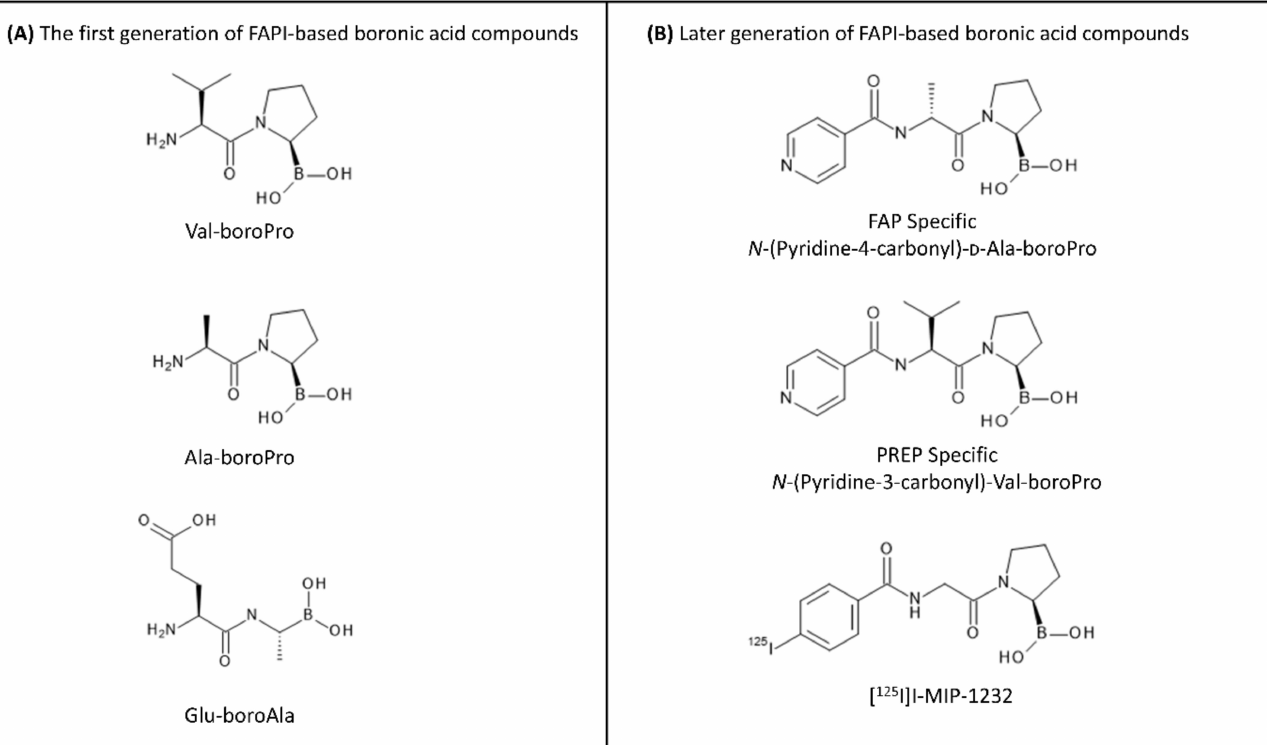
Figure 5. Different relevant FAPI molecules based on boronic acid warhead. ( A ) The first generation of boronic acid-based FAPIs: Val-boroPro, Ala-boroPro, and Glu-boroAla. ( B ) The later generation of FAP-targeted inhibitors: N -(Pyridine-4- carbonyl)-D-Ala-boroPro, N -(Pyridine-3-carbonyl)-Val-boroPro, and [ 125